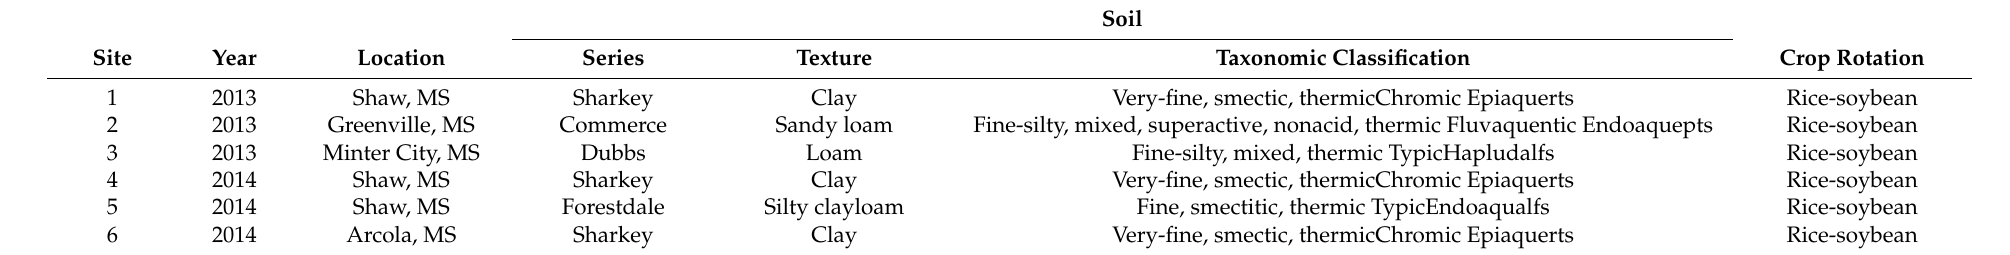
Table 1. Individual site locations, soil series, taxonomic classification, and crop rotation information for rice nitrogen (N) response tests were conducted comparing randomized complete block (RCB) and split-plot (SP) experimental designs in Mississippi in 2013 and